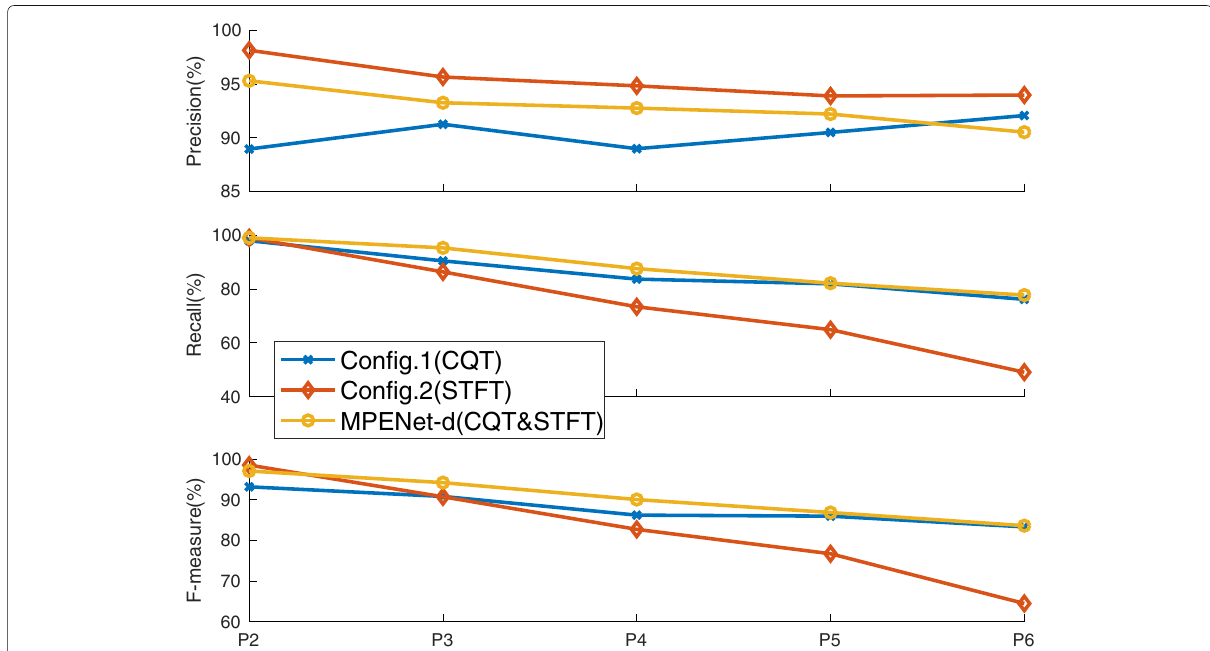
Fig. 8 Modality comparison results. Precision, Recall, and F-measure are shown in three subplots from top to bottom, respectively, where y axis indicates percentage value and x axis indicates polyphony level. Three subplots share same legends